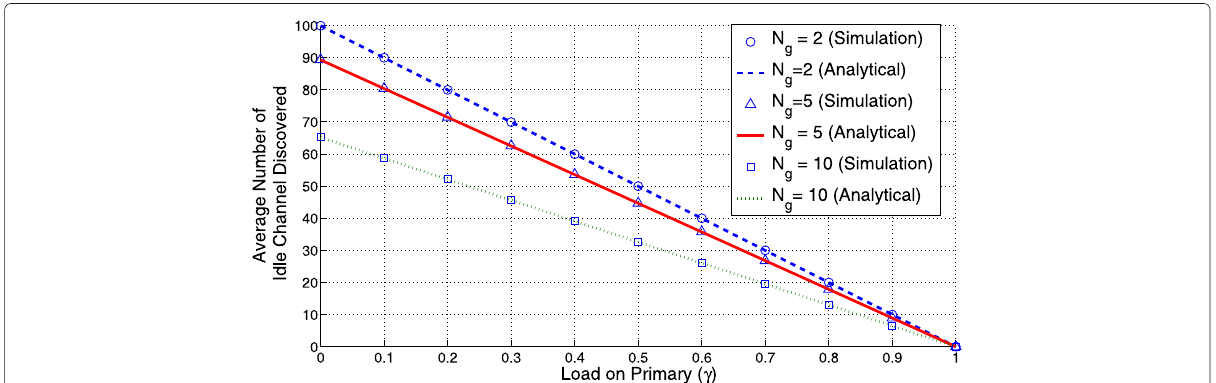
Fig. 10 Analytical and simulation comparison of average number of idle channels discovered by SUs when N su = 10